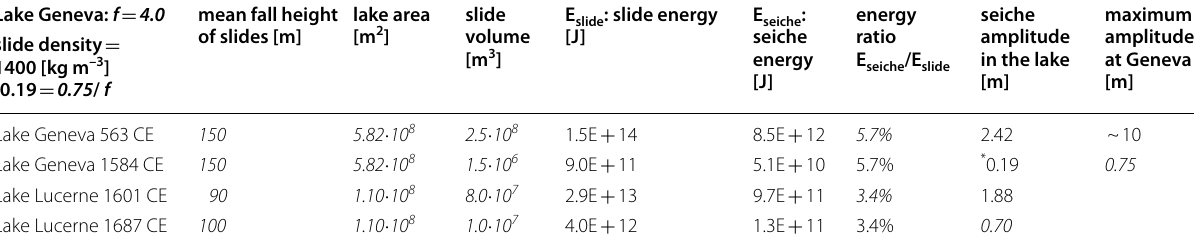
Table 1 The seiche/slide energy ratio of two events in Lake Lucerne and in Lake Geneva have been used to estimate the seiche amplitudes, see Chapter 5; italics indicate input data Lake Geneva: f =